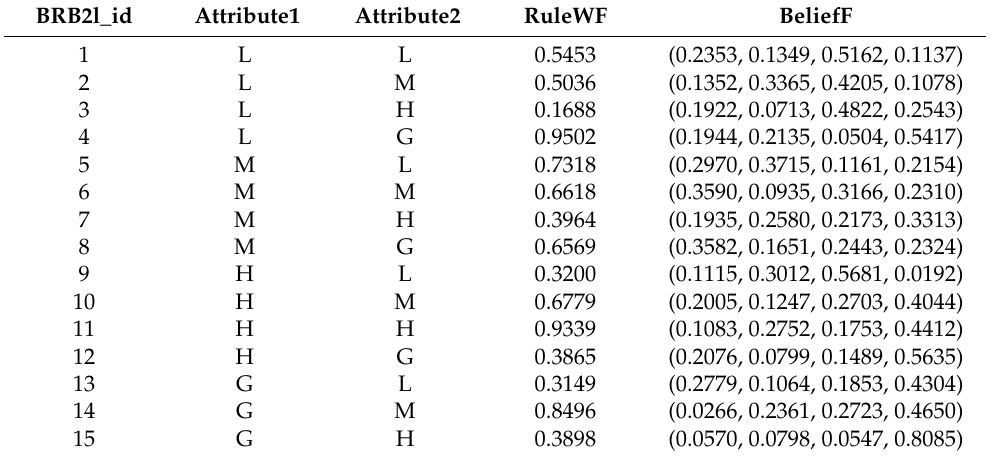
Table 6. Optimized parameters table in BRB2l.